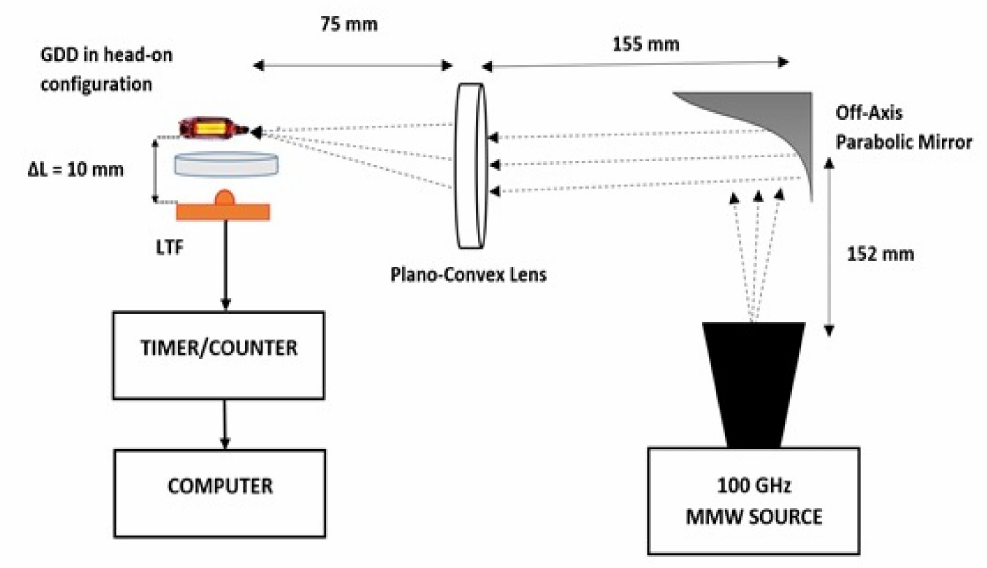
Figure 4. Experimental set up used for the minimum detectable signal and responsivity measurements.